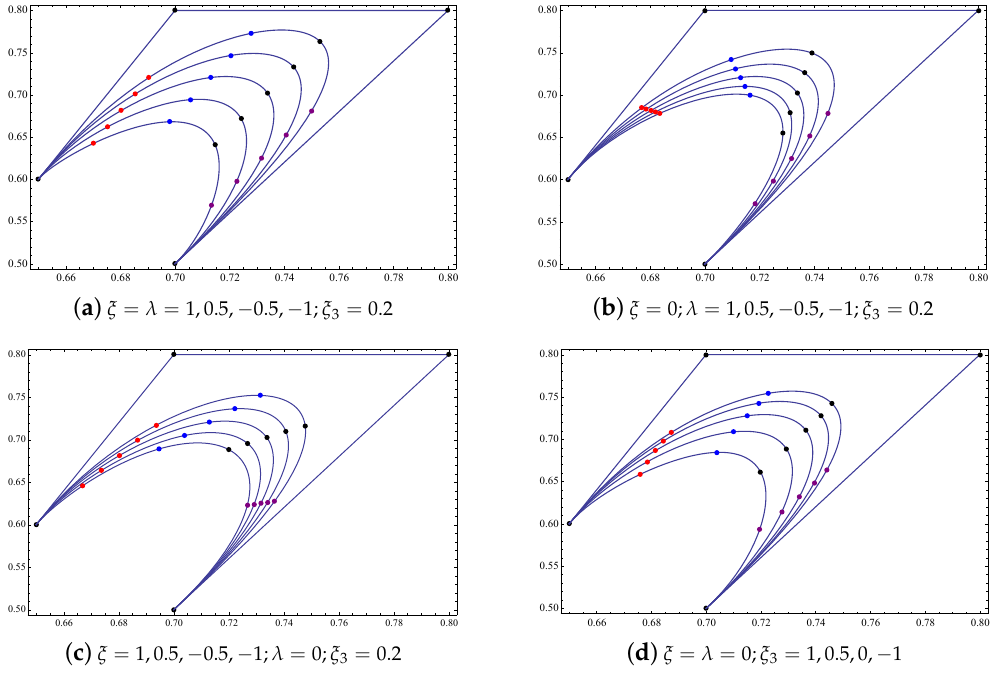
Figure 2. GHT-Bézier curves by multiple shape